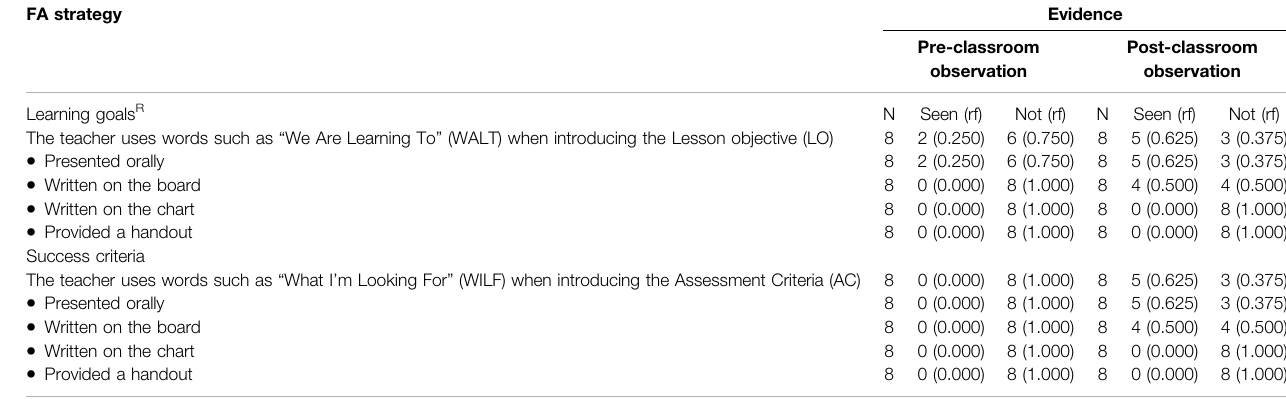
TABLE 3 | Rating frequency of the use of learning goal and success criteria within the FAHOTS as observed by the researcher pre- and post-observations. FA